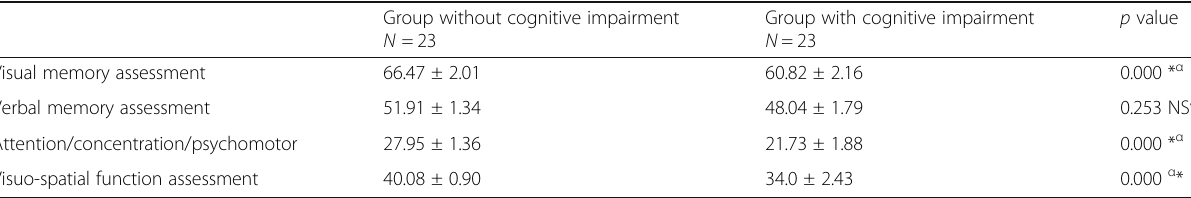
Table 6 Wechsler Memory Scale in both